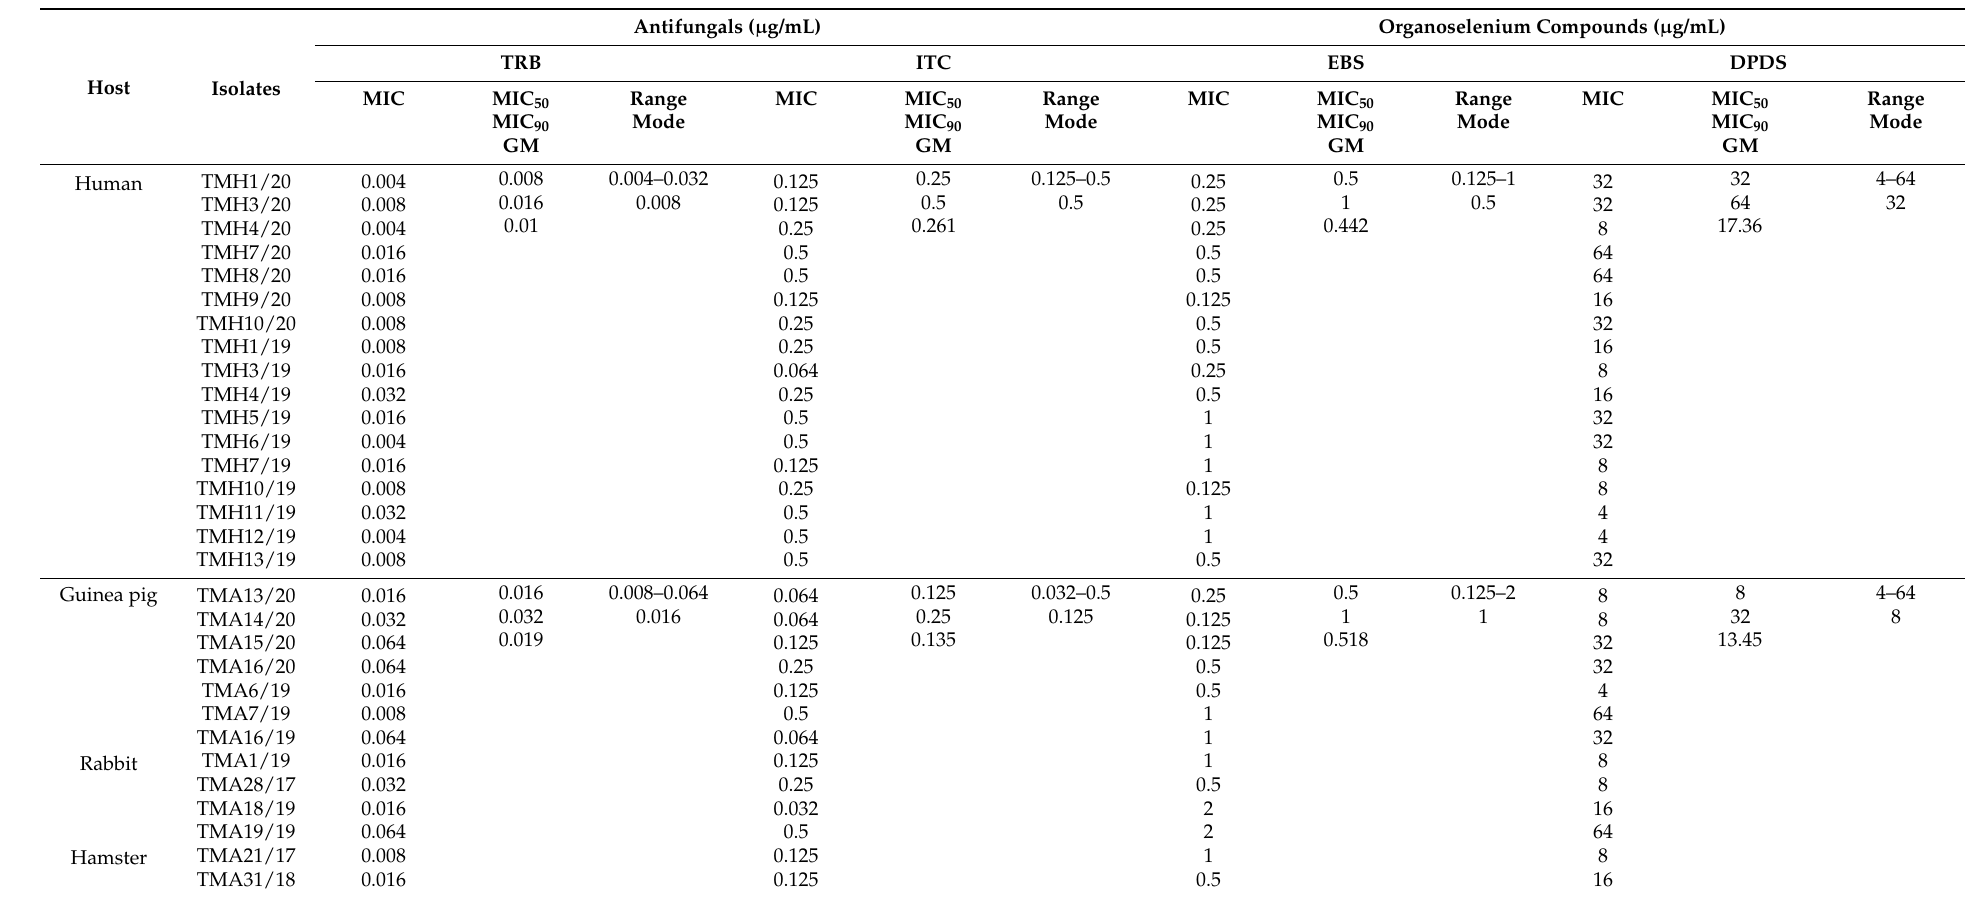
Table 2. The characteristics of clinical isolates of Trichophyton mentagrophytes and the values of the minimum inhibitory concentration (MIC) for known antifungal drugs and organoselenium